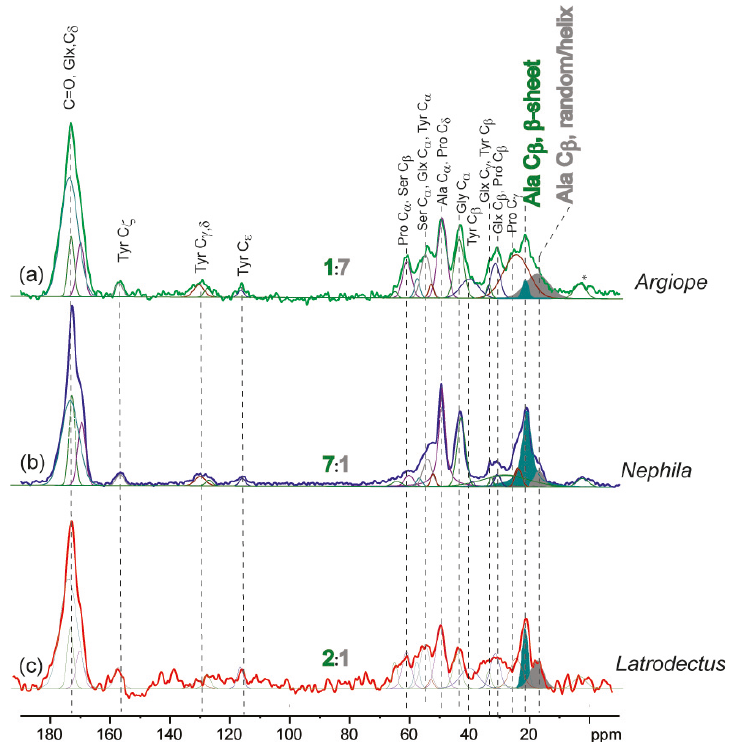
Figure 1. 13 C CPMAS ssNMR of silk from individual: ( a ) Argiope keyserlingi ( Argiope ); ( b ) Nephila plumipes ( Nephila ); and ( c ) Latrodectus hasselti ( Latrodectus ). The spectral peaks shaded green represent poly-alanine β -sheets, while those shaded grey represent poly-alanine 3,10 helices/random coils. Accordingly, the spectra show that there are differences in the ratios of alanine in β -sheets: alanine in 3,10 helices/random coil between A. keyserlingi (1:7), N. plumipes (7:1) and L. hasselti (2:1) silks . Spectra of individual spiders within each species are shown in the Supplementary Materials (Figure S1).